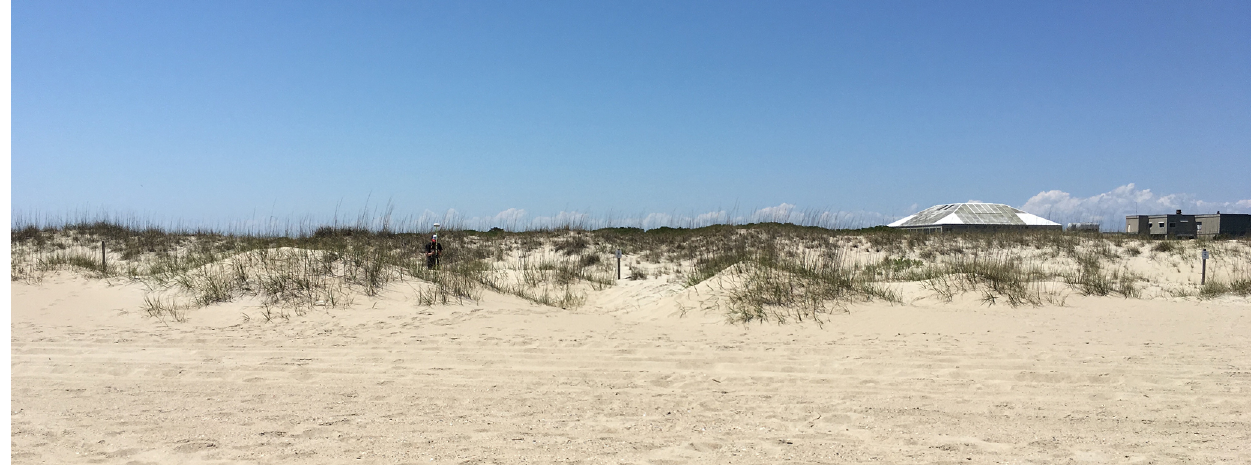
Figure 1. Ground-based photo of 1–2m hummocky foredunes covered with Uniola paniculata at Fort Fisher State Recreation Area, NC, USA. (Note the person in the center left wearing black with a 2m fixed height survey pole for scale). The hummocky foredunes are seaward of an older continuous dune